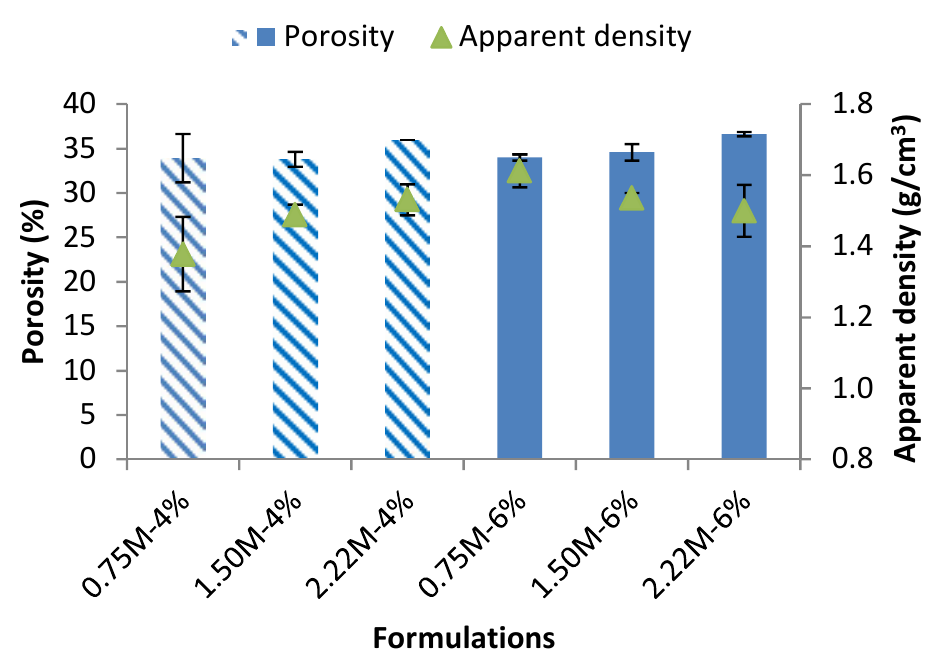
Figure 8. Apparent density and porosity of pastes.